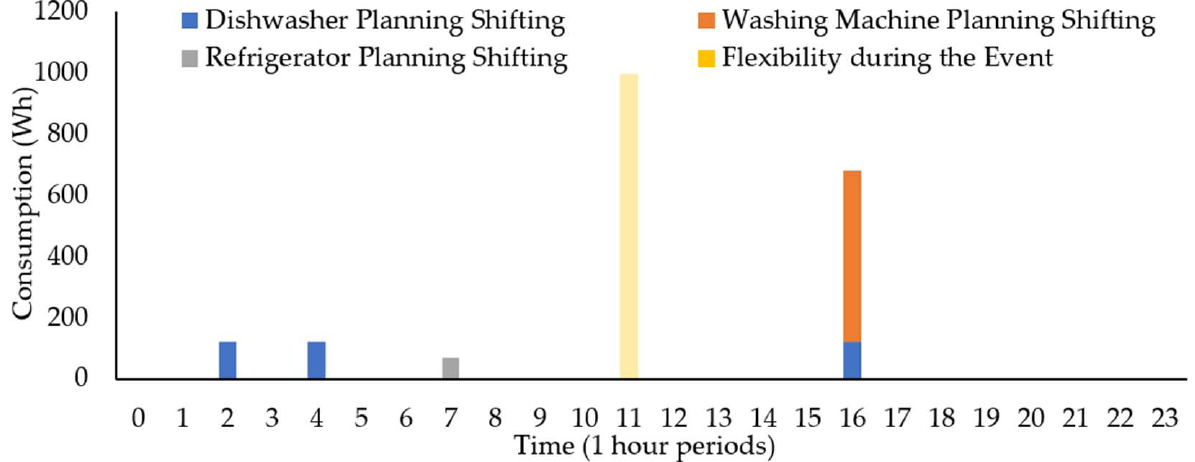
Figure 3. Shifting Distributions of end-user 2 to the demand response event at 11 h.